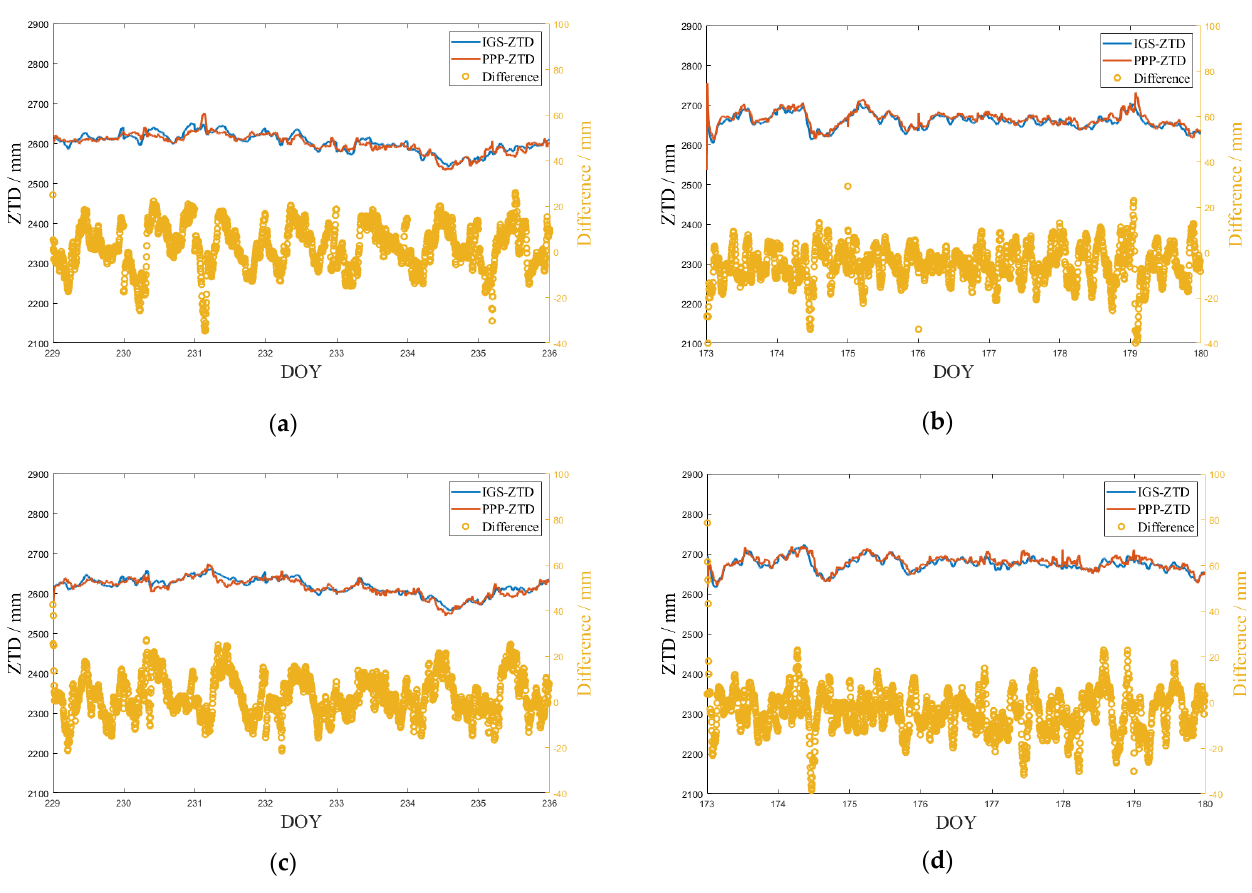
Figure 4. ( a ) Comparison of PPP-ZTD and IGS-ZTD at HKSL station during nonrainfall periods; ( b ) Comparison of PPP-ZTD and IGS-ZTD at HKSL station during rainfall; ( c ) Comparison of PPP-ZTD and IGS-ZTD at HKWS station during nonrainfall periods; ( d ) Comparison of PPP-ZTD and IGS-ZTD at HKWS station during rainfall. Table 5. Bias, STDEV, and RMS between PPP-ZTD and IGS-ZTD. Table 6. Bias, STDEV, and RMS between PPP-ZTD and